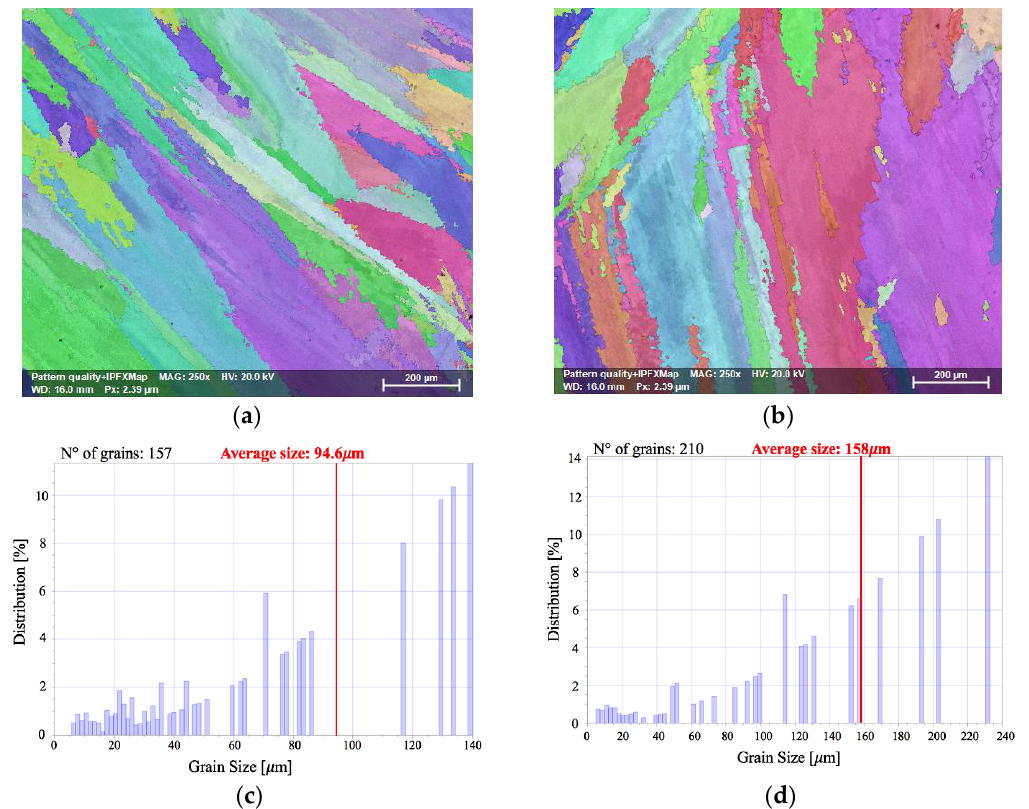
Figure 5. EBSD images of the ( a ) fusion line and the ( b ) weld metal. Below the EBSD images, are the distributions of grain size in the respective regions ( c , d ).